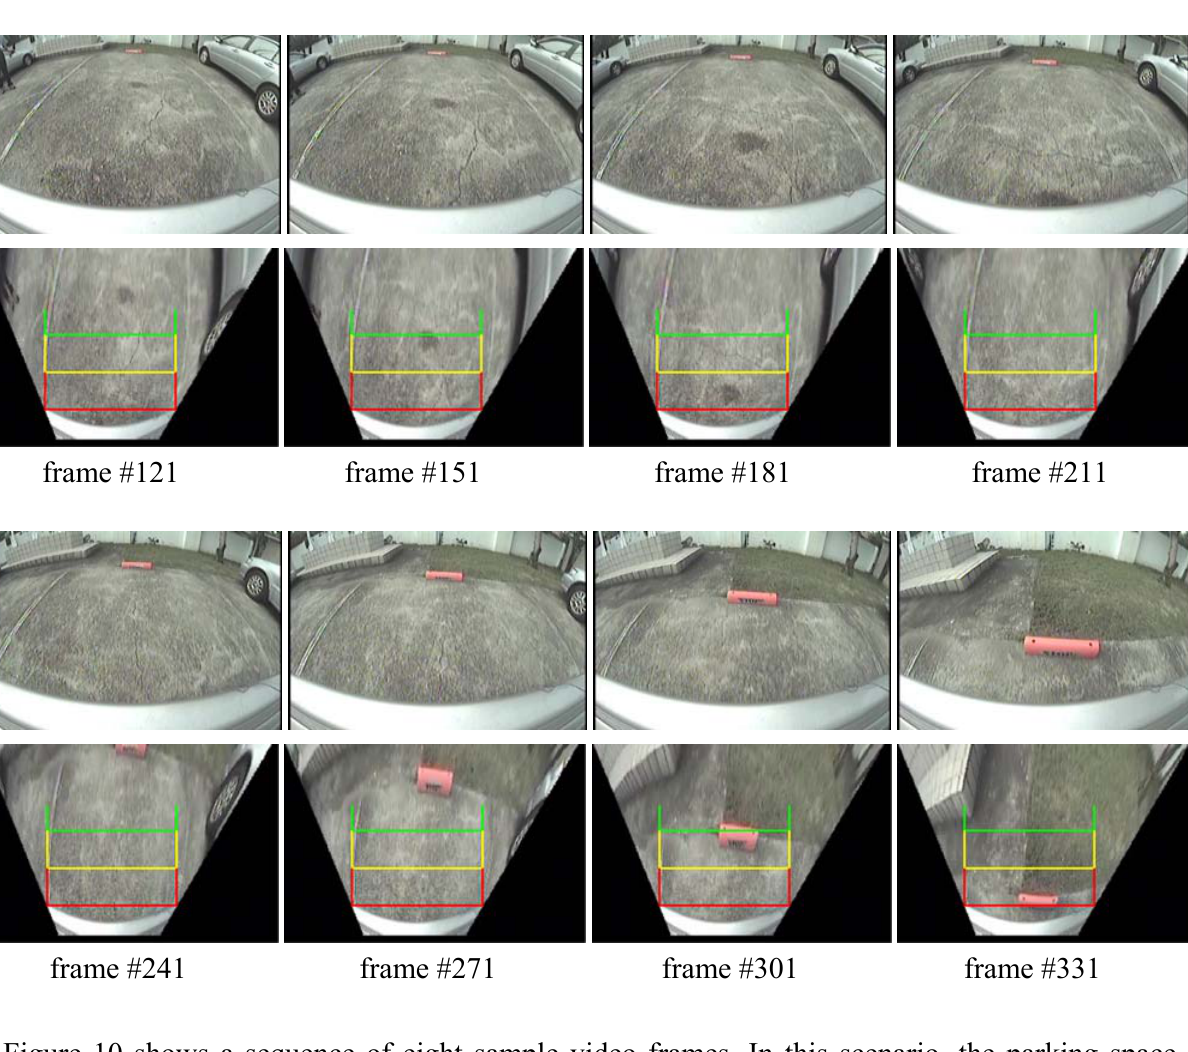
Figure 10. Experimental results for direct backward parking with θ = 45°. In each image frame, the top one is the source image and its TVTM result is shown at the